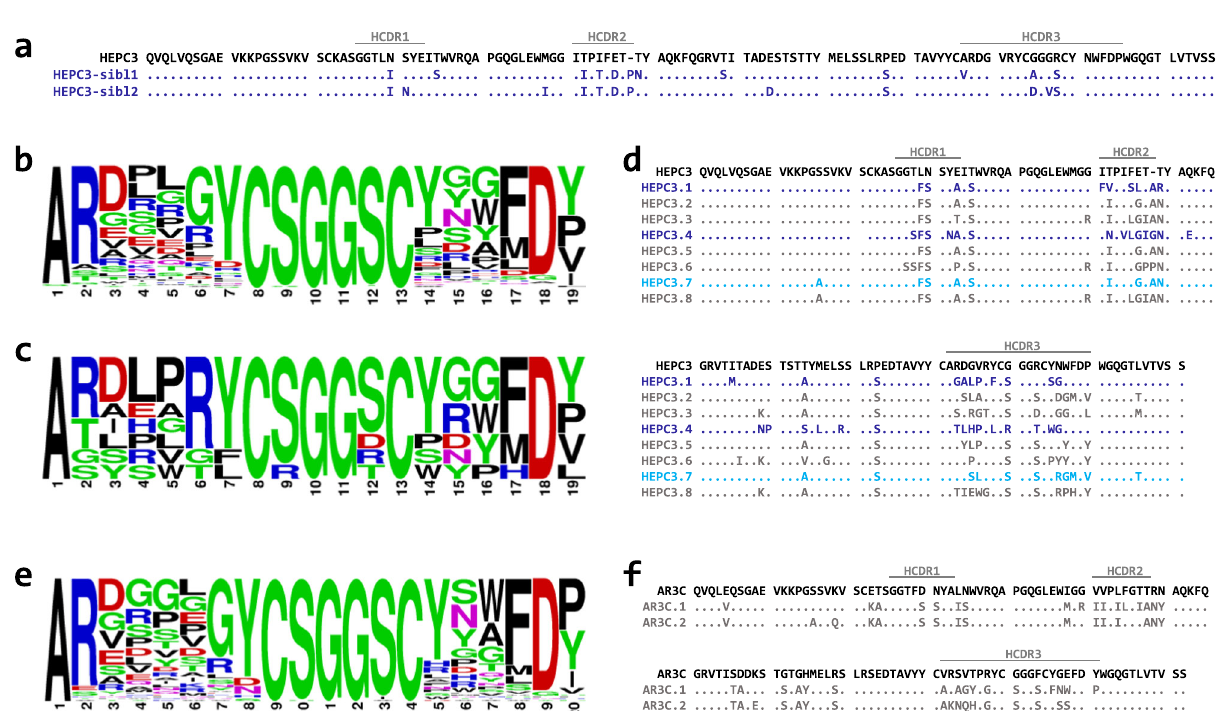
Fig. 1 Analysis of HCDR3 loop diversity in the obtained heavy chains sequences library and sequences of the Abs selected for testing. a , d , f Alignments of the amino acid sequences of the heavy chain variable regions of a HEPC3 with its sibling Abs, d HEPC3 with selected by the P3SM approach HEPC3-like Abs, and f AR3C with selected by the P3SM approach AR3C-like Abs. Dots indicate the same amino acid as in the reference Ab sequence. Positions of the HCDR loops (IMGT de fi nition) are marked above the alignment. b , c , e Amino acid frequency distribution in b all found HEPC3- like, c 8 selected by the P3SM approach HEPC3-like, and e all found AR3C-like HCDR3 loops. Amino acid frequency distributions were analyzed and visualized using WebLogo (https://weblogo.berkeley.edu/logo.cgi) web